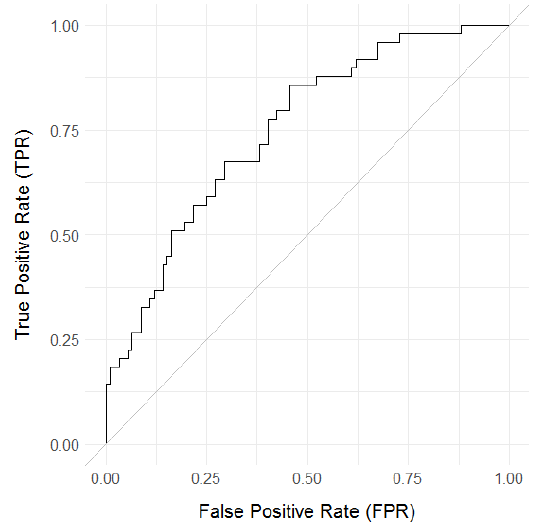
Figure 3. Graph of the Receiver Operating Characteristic (ROC) curve corresponding to the binary logistic regression model computed for the Daylight Glare Probability (DGP) index calculated with t4_def evalglare option on the field study dataset (AUC = 0.7496).